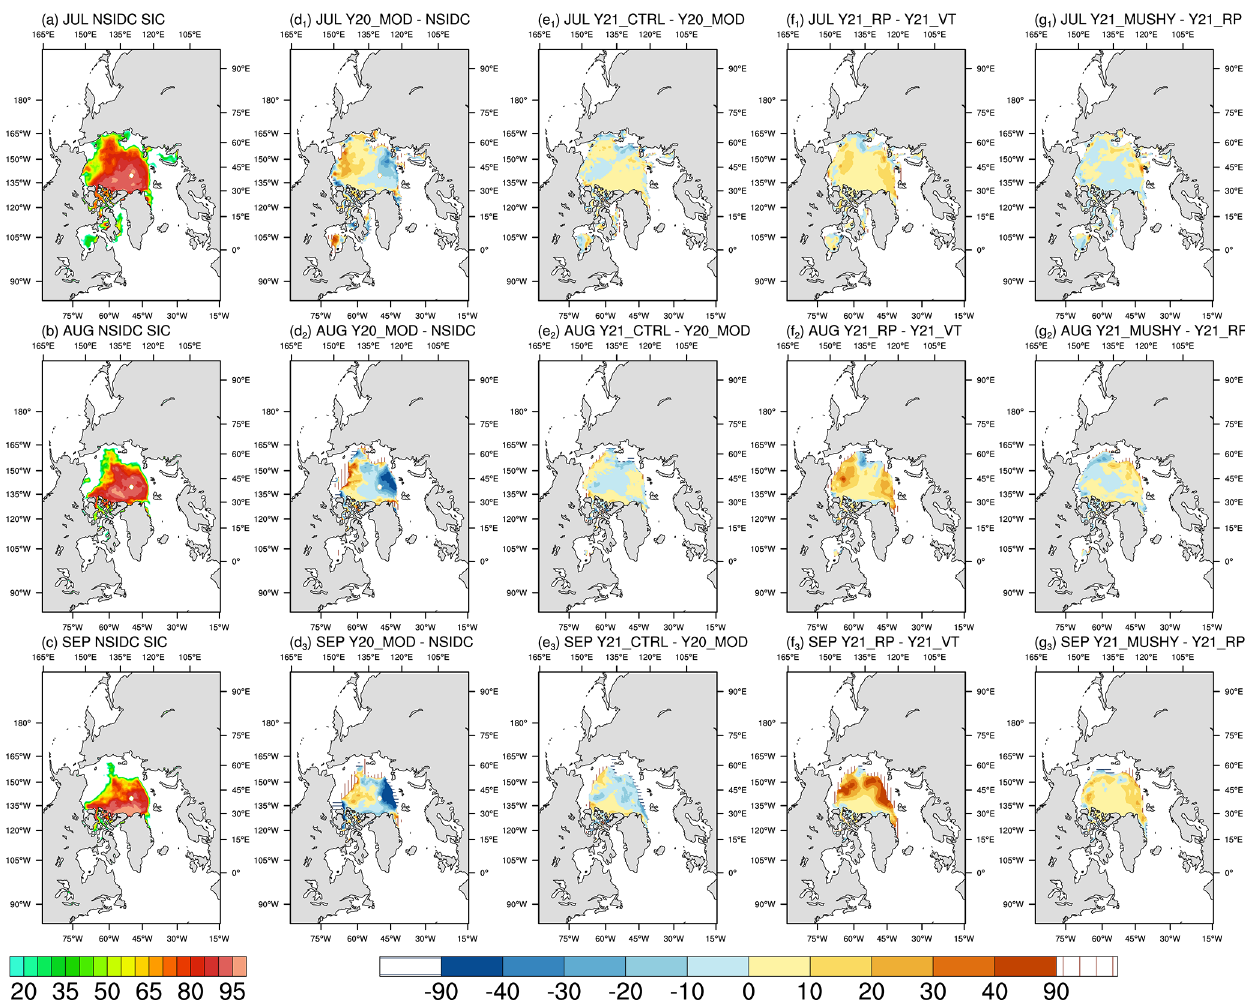
Figure 5. Monthly mean of sea ice concentration for (a) July, (b) August, and (c) September of the NSIDC observations, and the differ- ence between the all prediction experiments and the observations for (d 1 –g 1 ) July, (d 2 –g 2 ) August, and (d 3 –g 3 ) September. Vertical- and horizontal-line areas represent the difference of ice edge location (15%